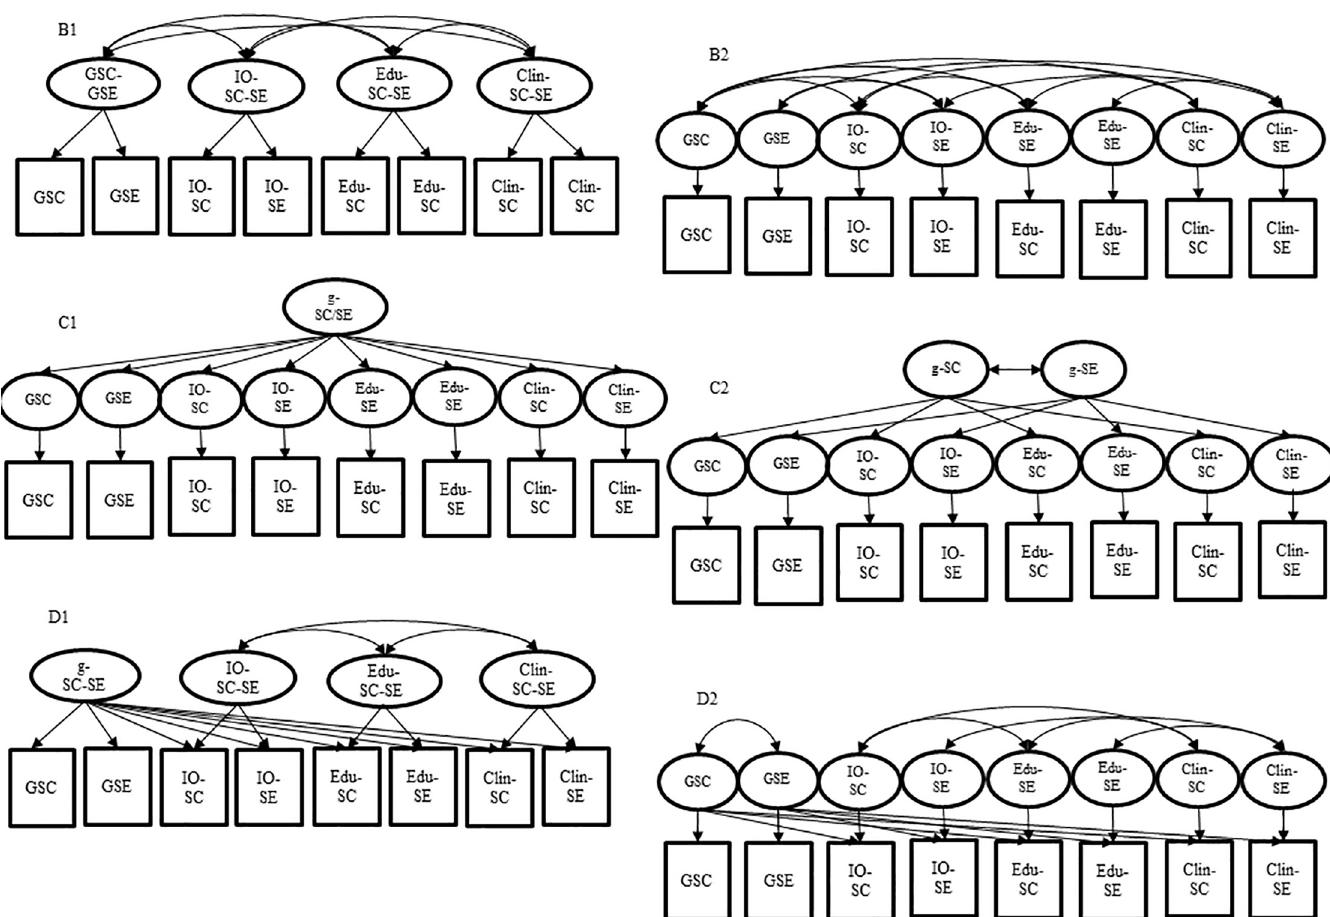
Fig 2. B1-D2. Six different combined structural models of ability self-concept and self-efficacy in higher education. SC = Ability self-concept; SE = Self-efficacy; IO = Industrial and Organizational psychology; Edu = Educational psychology; Clin = Clinical psychology; GSC = General self-concept; GSE = General self-efficacy; g = General